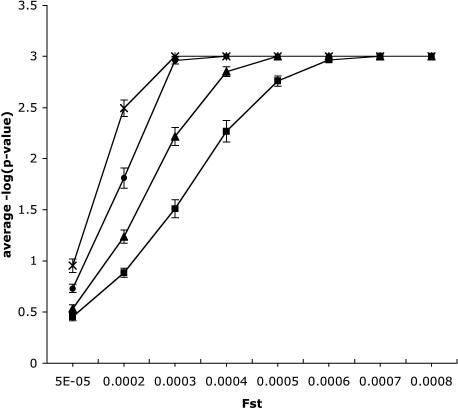
Relationship between the Genetic Differentiation among Two Populations as Measured by Wright's F
ST and the Average (±S.E.M.) Power of the GAMOVA Procedure to Detect that DifferentiationResults are based on 1,000 simulation studies involving four sets of two equally sized populations, each generated according to varying genetic differentiation. Known group membership was used as predictor in the GAMOVA analysis. For a constant data size (number of markers × number of subjects), genetic differentiation can be detected at lower F
ST values in larger populations with fewer markers compared to smaller populations with more markers (squares: 32 individuals, 32768 markers; triangles: 64 individuals, 16384 markers; circles: 128 individuals, 8192 markers; stars: 256 individuals, 4096 markers).